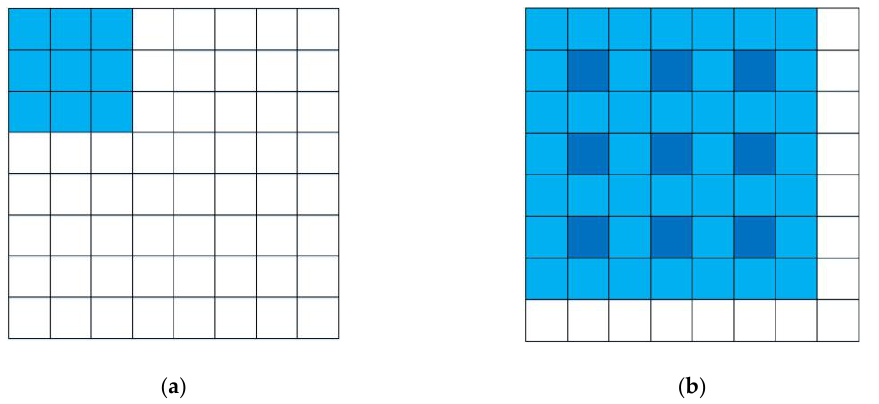
Figure 4. Local receptive fields: ( a ) dilated convolution kernel with rate = 1; ( b ) dilated convolution kernel with rate = 2.